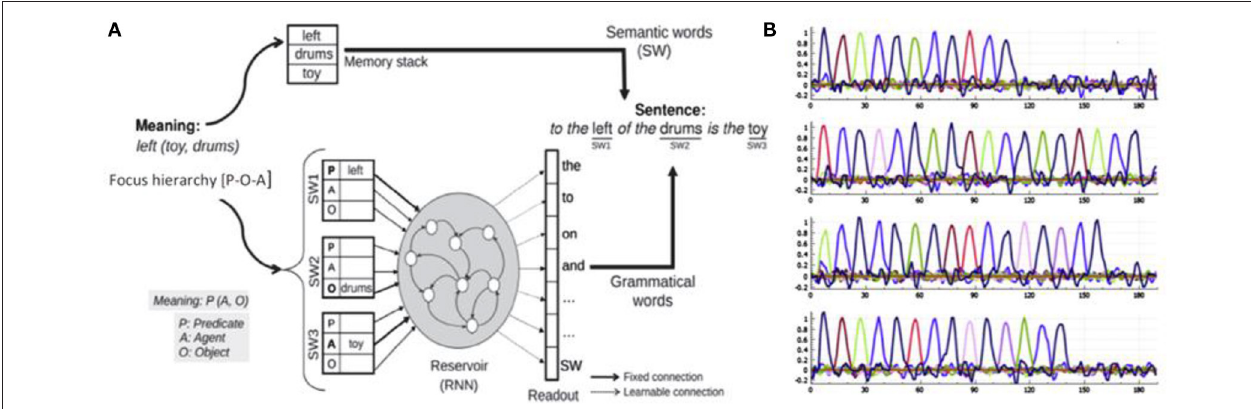
FIGURE 4 | Sentence production model. (A) The input should express two aspects of the meaning: (1) meaning format [Predicate(Agent, Object)—left(toy, drums)] corresponding to relation toy to the left of drums, and (2) the focus hierarchy indicating [SW1—Predicate, SW2—Object, SW3—Agent] which could be written in a compact way a [P-O-A]. The system must find a construction that allows this mapping of SWs to thematic roles. (B) Sample activation of readout neurons for 4 different